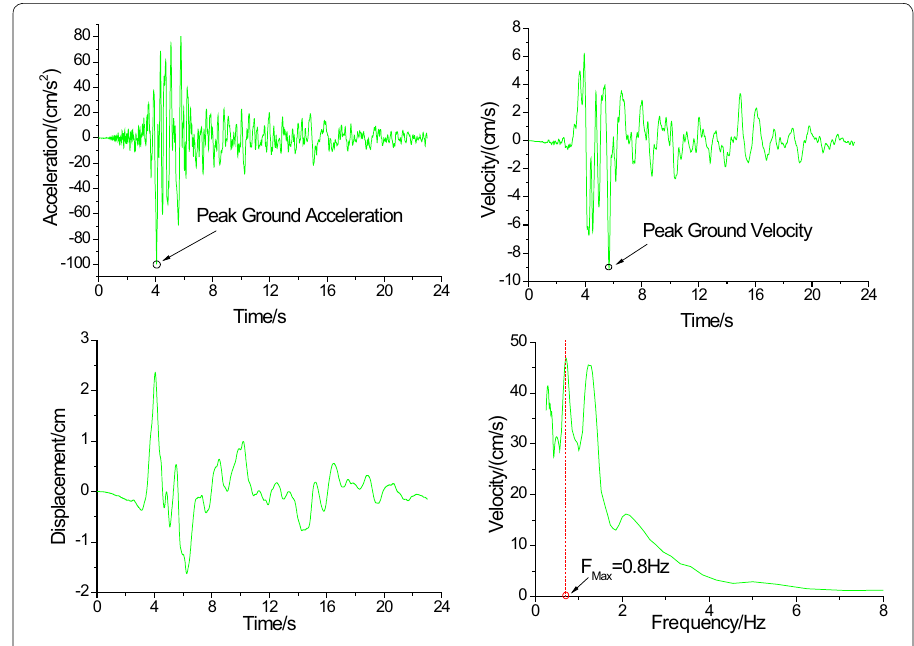
Fig. 8 Data time-history of Loma Prieta earthquake (PGA